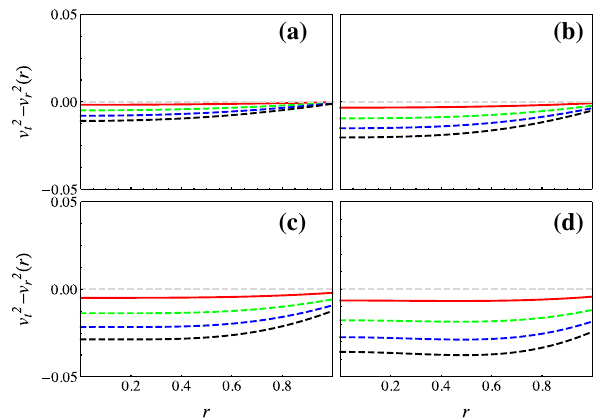
Fig. 10 Anti–cracking condition for M = 0 . 2, R = 1, c 1 = 0 . 5 and a C = − 0 . 1, b C = − 0 . 2, c C = − 0 . 3, d C = − 0 . 4. α = 0 . 1 (red line), α = 0 . 3, (green line), α = 0 . 5 (blue line), α = 0 . 7 (black